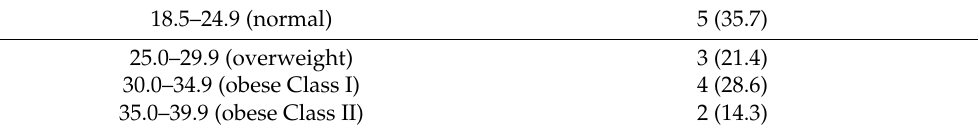
Table 8. BMI of patients who performed regulary exercise after